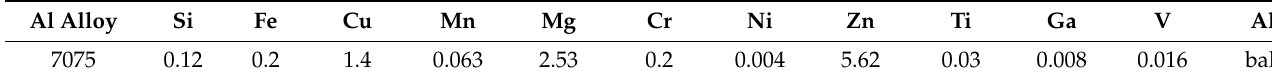
Table 3. Chemical composition (wt.%) of 7075 aluminum alloy.